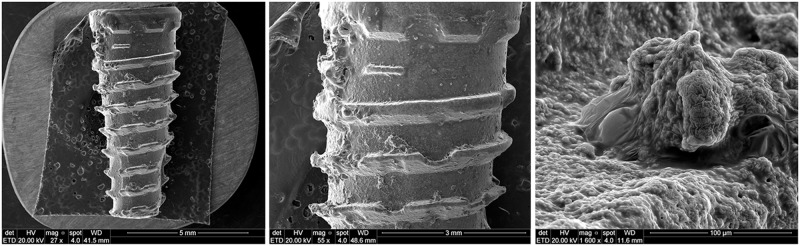
In (a) an image of low magnification of the implant showing the deposition of bone tissue over the entire surface and the presence of larger lumps of bone tissue in several areas of the implant body. In (b) an image with more increase showing the bone tissue is deposited on the implant surface and the big quantity of bone tissue. In (c) an image with great increase showing the deposition of bone tissue on the implant with signs of consistent and even layer on the surface.